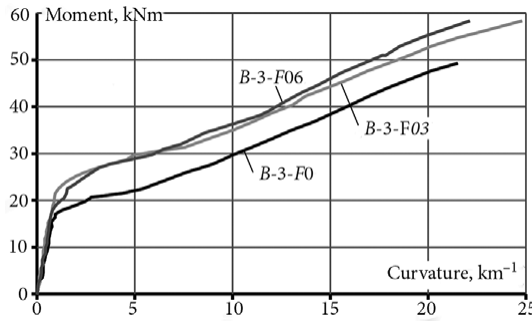
Fig. 7. Experimental curvatures of the steel fibre reinforced concrete beams with bar reinforcement